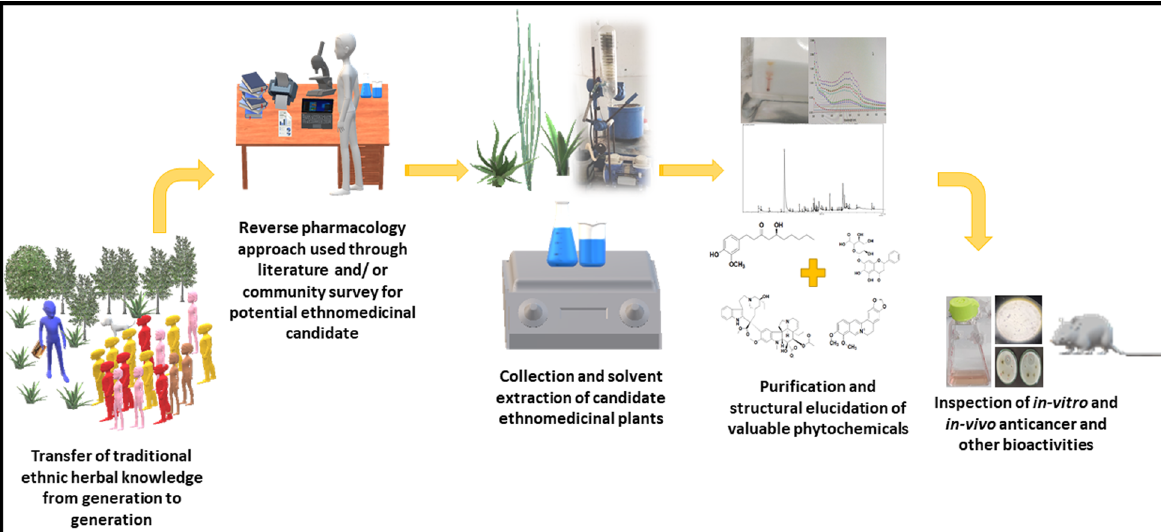
Fig. 1 Overview of experimental process involved in the translation of traditional herbal healing knowledge into modern